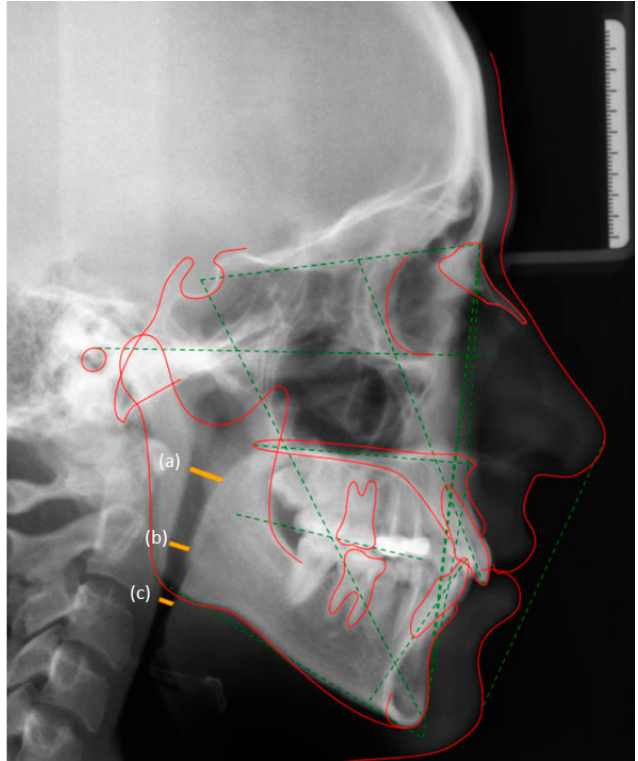
Figure 1. Measurement of ( a ) naso-pharyngeal, ( b ) oro-pharyngeal and ( c ) hypo-pharyngeal air- way spaces on two-dimensional lateral cephalometric radiographs. spaces on two-dimensional lateral cephalometric